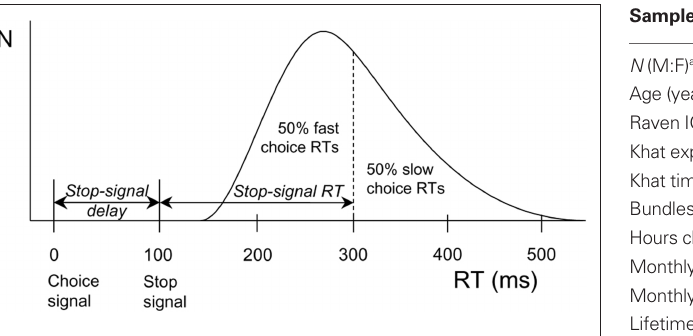
FiguRe 1 | Calculation of stop-signal RT (SSRT) according to a race model. The curve depicts the distribution of RTs on go trials (trials without a stop signal) representing the finishing times of the response processes. Assuming independence of go and stop processes, the finishing time of the stop process bisects the go RT distribution. Given that the button-press response could be withheld in 50% of all stop trials, stop-signal RT (200 ms) is calculated by subtracting the mean stop-signal delay (100 ms) from the median go RT (300